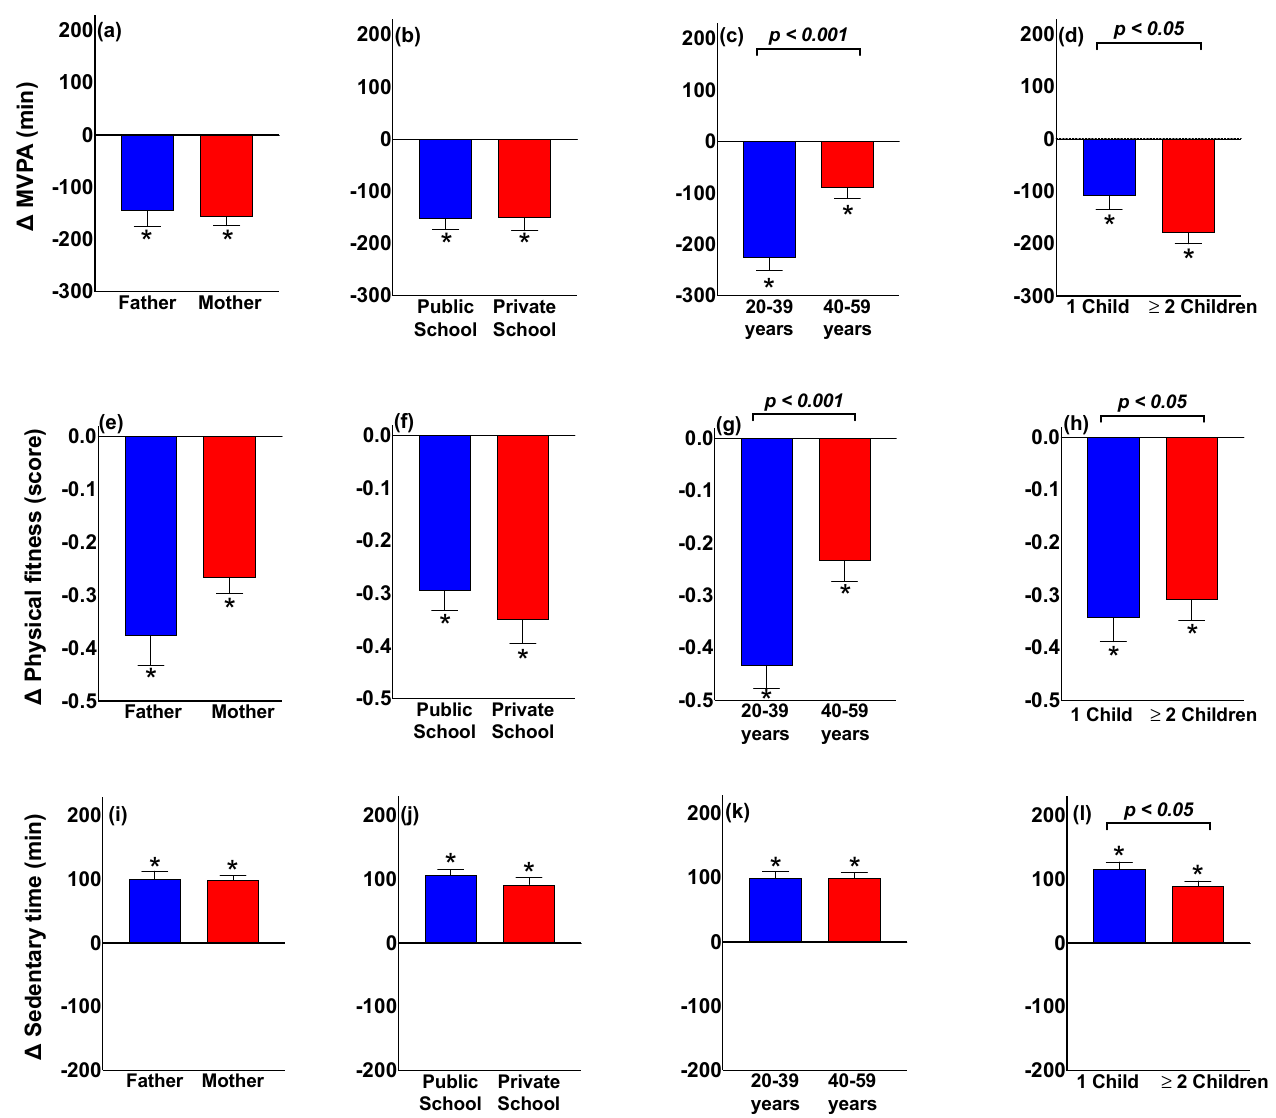
Figure 2. Influence of the COVID-19 pandemic on the variation in MVPA, physical fitness, and sedentary time by sex of parents, children’s school type, age group and the number of children by family. ANCOVA models were adjusted by age, sex, and children’s school type, except when the variables were used to stratify the data; MVPA: moderate-to-vigorous physical activity; * p < 0.05 compared with the value before the pandemic. ( a ) Variation after-during of MVPA between fathers and mothers, ( b ) Variation after-during of MVPA by children’s school type, ( c ) Variation after-during of MVPA by parents age group, ( d ) Variation after-during of MVPA by the number of children in the family, ( e ) Variation after-during of physical fitness between fathers and mothers, ( f ) Variation after-during of physical fitness by children’s school type, ( g ) Variation after-during of physical fitness by parents age group, ( h ) Variation after-during of physical fitness by the number of children in the family, ( i ) Variation after-during in sedentary time between fathers and mothers, ( j ) Variation after-during in sedentary time by children’s school type, ( k ) Variation after-during in sedentary time by parents age group, ( l ) Variation after-during in sedentary time by the number of children in the